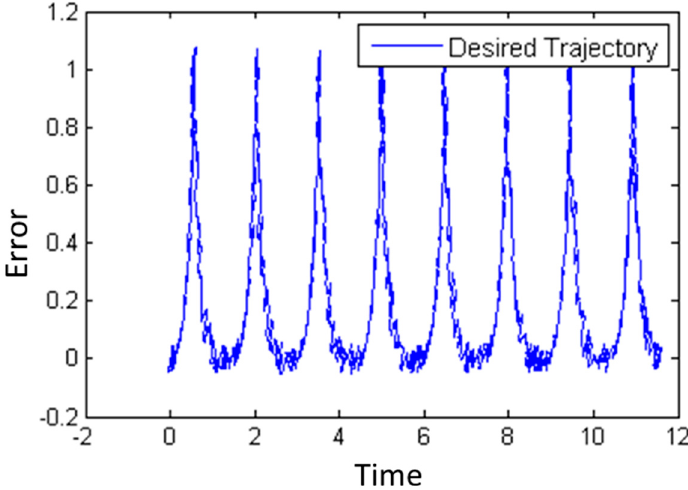
Figure 12. Desired trajectory for the autonomous mobile robot, with noise.